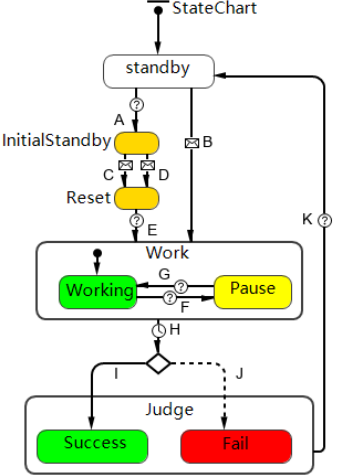
Figure 3. The statechart for unit task agent.